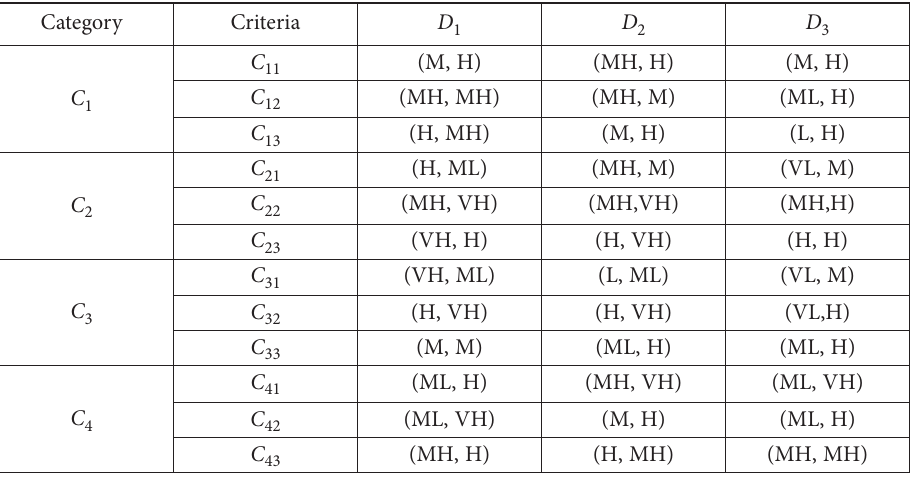
Table 5. Importance weight of Subjective criteria assessed by decision makers